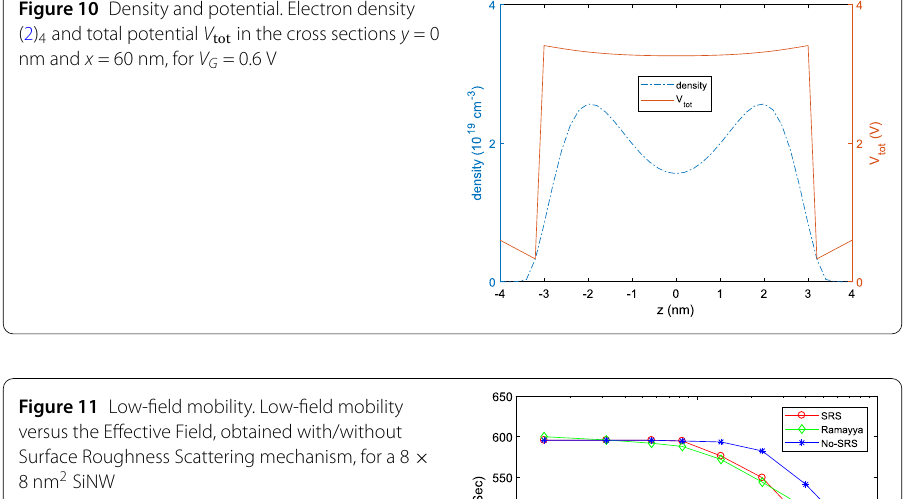
Figure 11 Low-field mobility. Low-field mobility versus the Effective Field, obtained with/without Surface Roughness Scattering mechanism, for a 8 ×